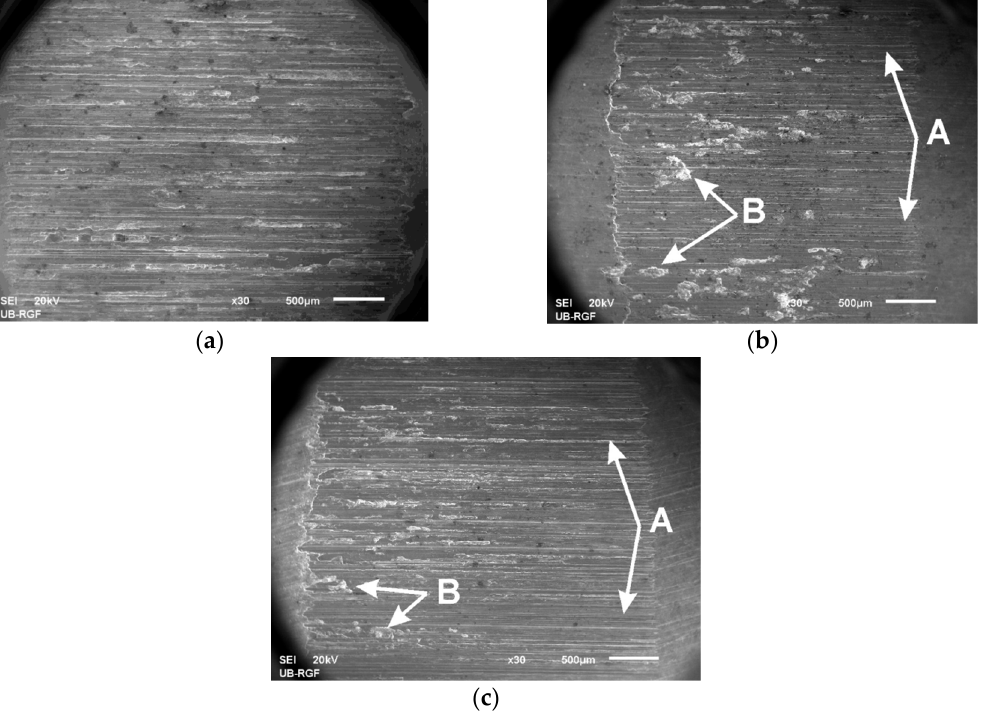
Figure 7. The appearance of the worn surfaces of the tested materials taken by SEM: ( a ) ZA27 alloy; ( b ) ZA27/5%SiC composite; ( c ) ZA27/5%SiC/3%Gr hybrid composite. ( b ) ZA27 / 5%SiC composite; ( c ) ZA27 / 5%SiC / 3%Gr hybrid